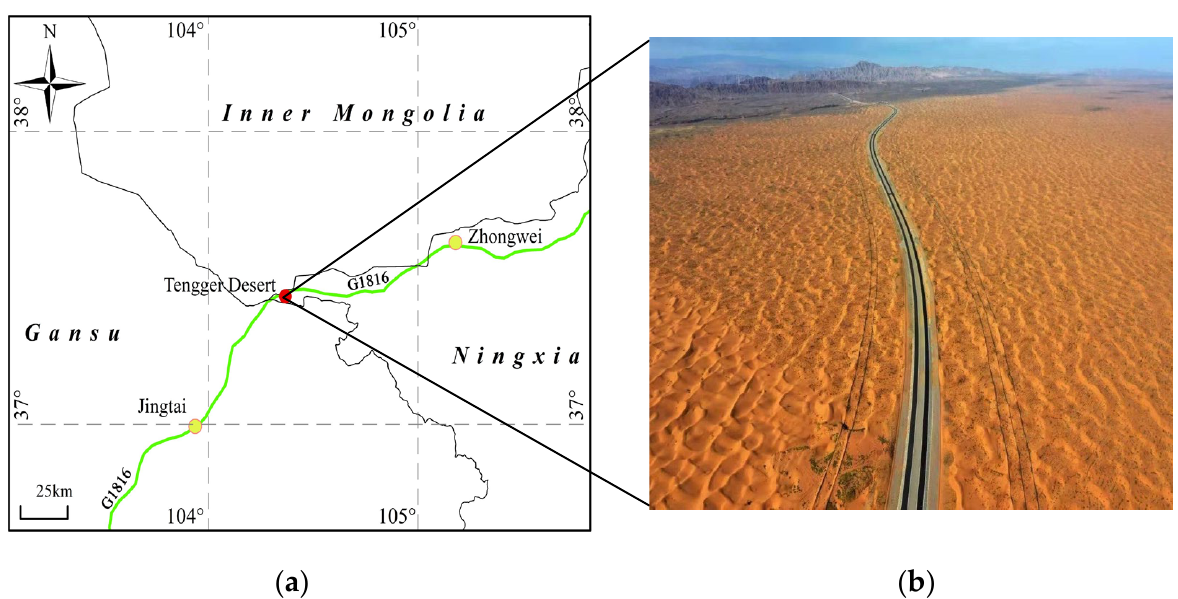
Figure 1. Picture of sand-accumulation environment in drifting sand dunes areas: ( a ) desert route and ( b ) aeolian landform environment.